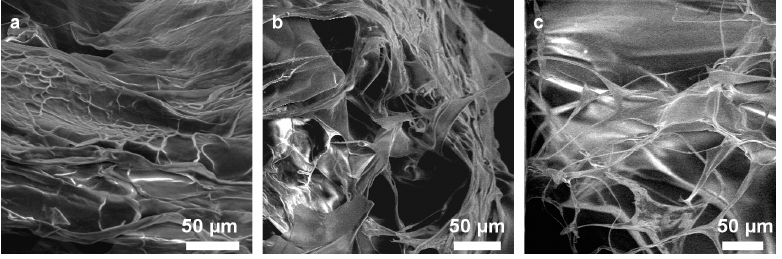
Figure 2. Representative SEM micrograph of dry gelatin samples: ( a ) pristine gelatin; ( b ) gelatin treated with 4 10 µmol; ( c ) gelatin treated with 5 10 µmol.